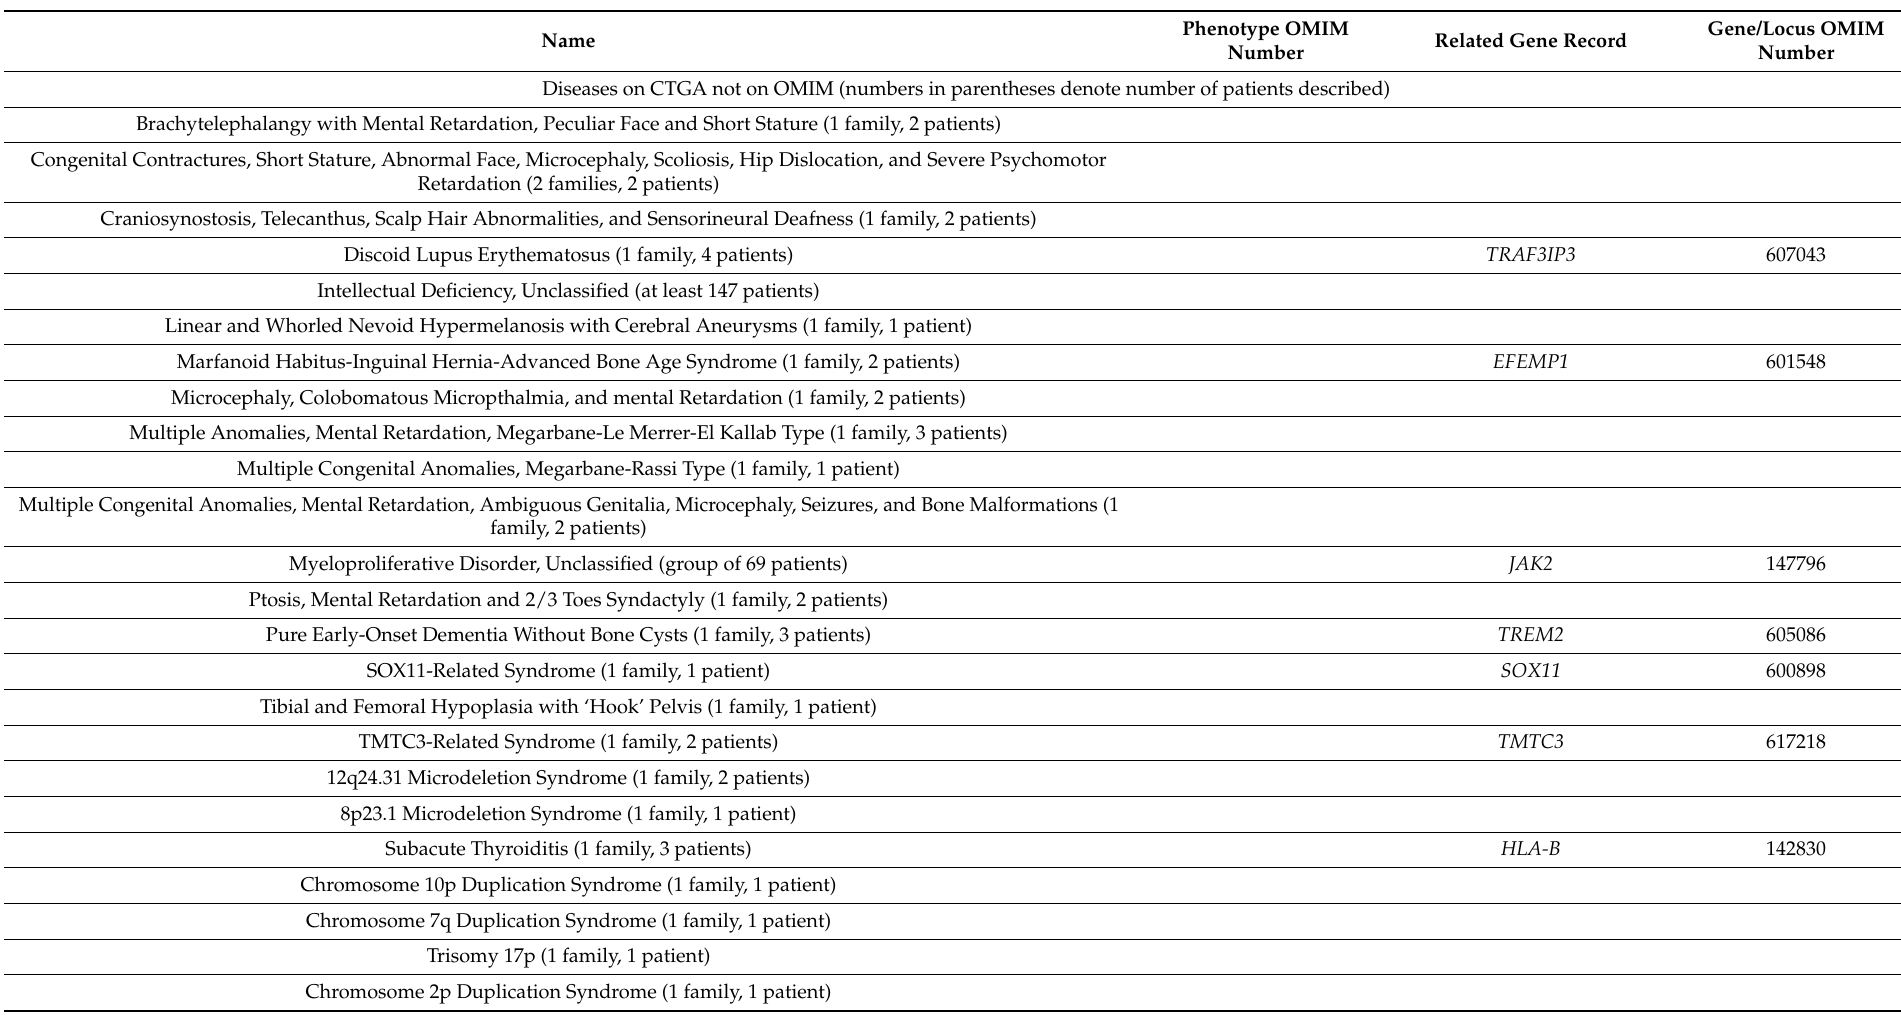
Table 1. List of selected diseases in the CTGA Database with Lebanese subjects. Rows marked with * indicate diseases reported exclusively in Lebanese subjects. Rows marked with # indicate diseases that were first mapped in Lebanese subjects. Complete list of records is available in Supplementary Table